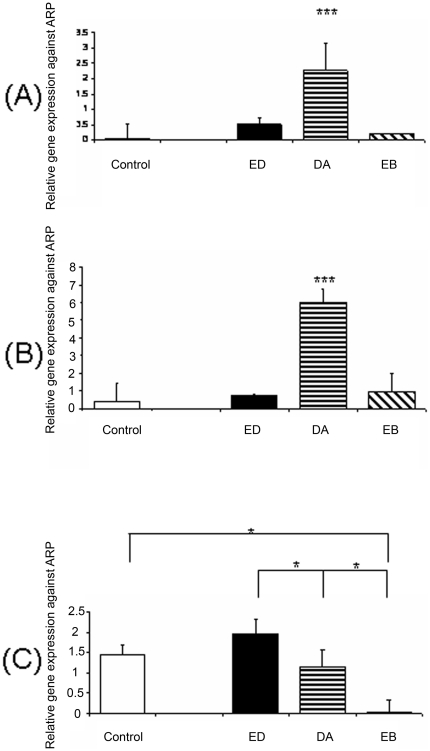
The concentration of EPO administered i.p. alters growth factors and cytokines mRNA in the retina.(A & B) TNF-alpha and VEGF was higher with darbepoetin alfa relative to the control. (n = 6***p<0.001). (C) IL-10 was reduced with EPO treatment only with Epoetin Beta. (n = 6) (*p<0.05;) (Error bars  =  Standard Error of the Mean).